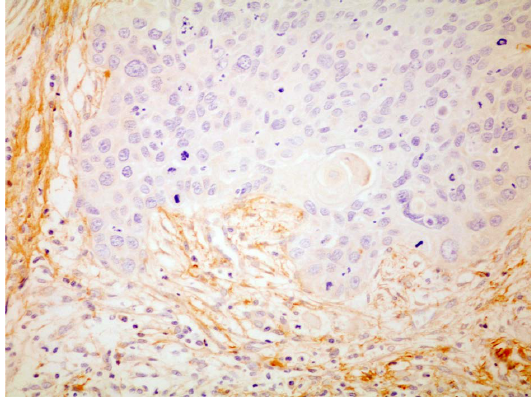
Figure 6. Immunoexpression of type I collagen in tumor stroma of SCCLi in fibrillar pattern (LSAB method, original magnification